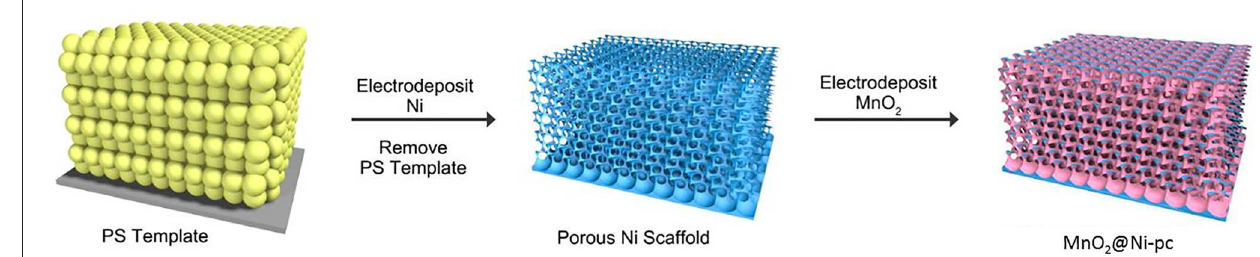
and 0.89 mA cm − 2 ) and MnO 2 @Ni foil ( Figure 2a 0.71 V and 1.65 mA cm − 2